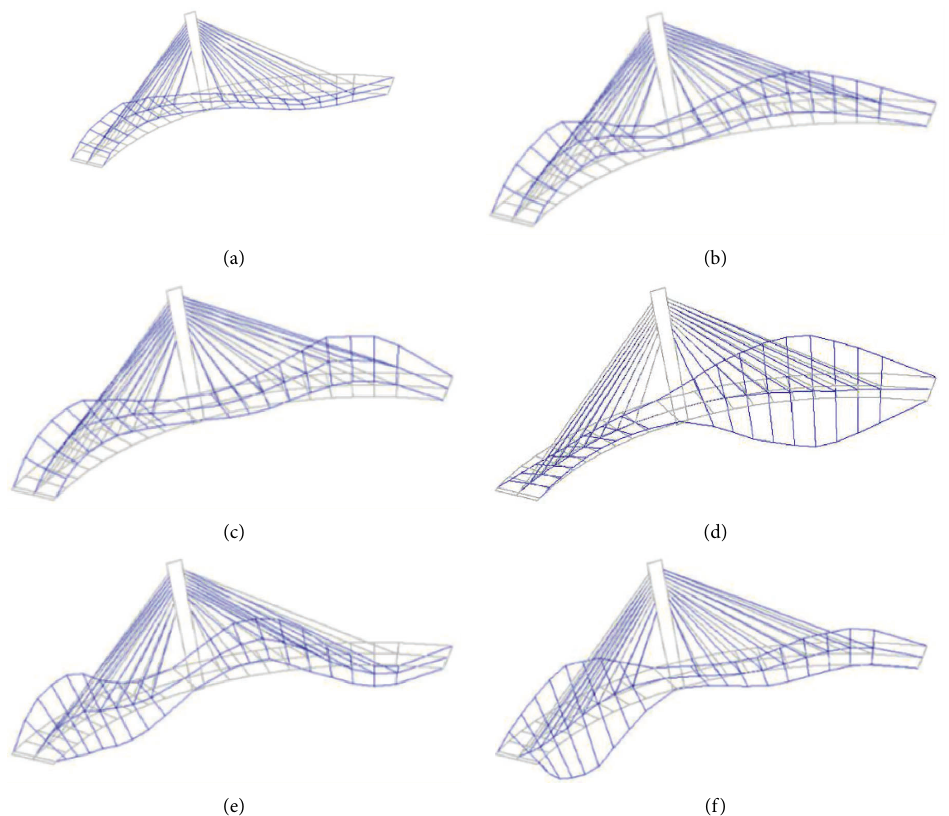
Figure 12: The representative experimental modes identified by the testing. (a) Mode 1 with f � 0.635Hz.(b) Mode 2 with f � 0.996 Hz. (c)